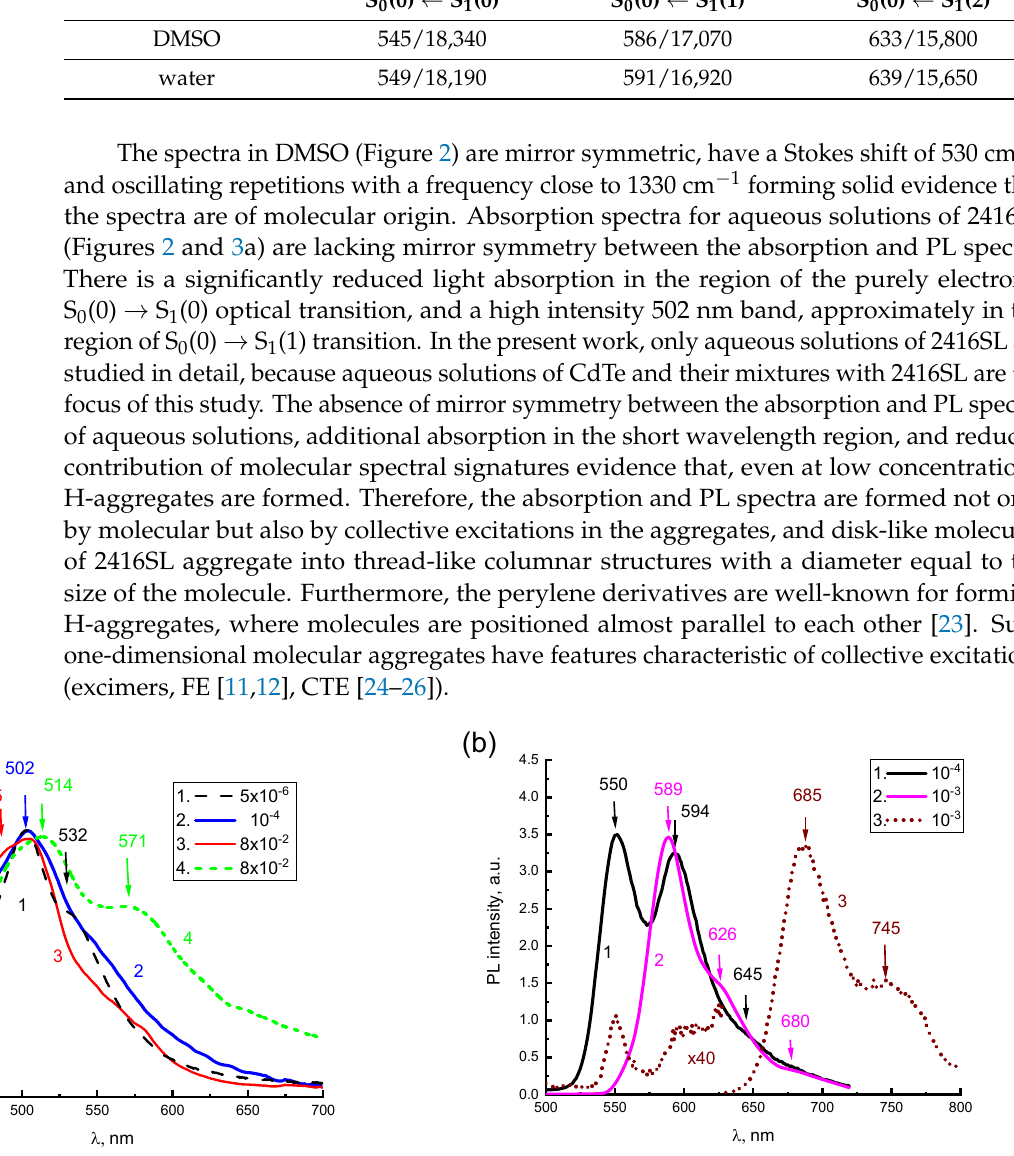
Figure 3. ( a ) Absorption spectra of aqueous solutions for 2416SL at the concentrations of 5 · 10 − 6 M (1), 10 − 4 M (2), and 8 · 10 − 2 M (3,4); λ e = 405 nm; T = 296 K (1–3) and 77 K (4). ( b ) Steady-state PL spectra of aqueous solutions for 2416SL at the concentrations of 10 − 4 M (1) and 10 − 3 M (2,3); λ e = 405 nm; T = 296 K (1,2) and 4.2 K (3).